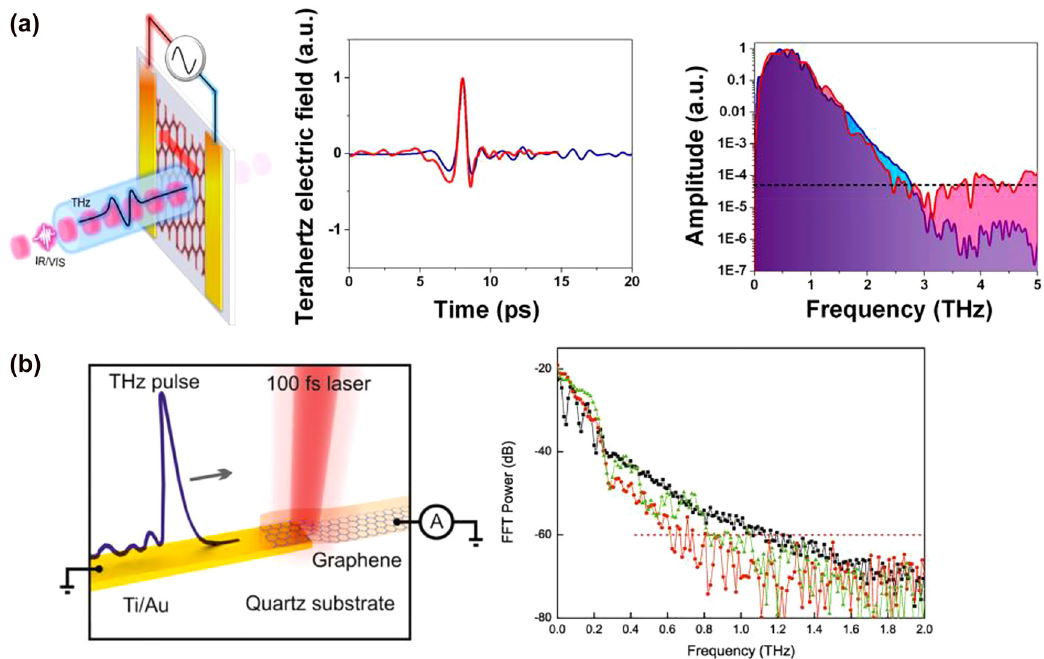
Figure 14: (a) Schematic of the graphitic photoconductive terahertz detector (left), the measured time-domain electric field (middle), and the amplitude spectra (right) from the graphitic detector (in red) as compared to the reference data measured by conventional electro-optic sampling (in blue). The dashed black line indicates the noise level of the graphitic detector measurement. Reprinted (adapted) by permission from [166]. Copyright (2019) by American Chemical Society. (b) Schematic of the guided-wave graphene photoconductive terahertz detector (left) and the measured terahertz power spectra (right) at the transmission line input by LT-GaAs (black squares), at the transmission line output by graphene (red circles), and at the transmission line output by LT-GaAs (green triangles). The dashed red line indicates the noise level. Adapted from